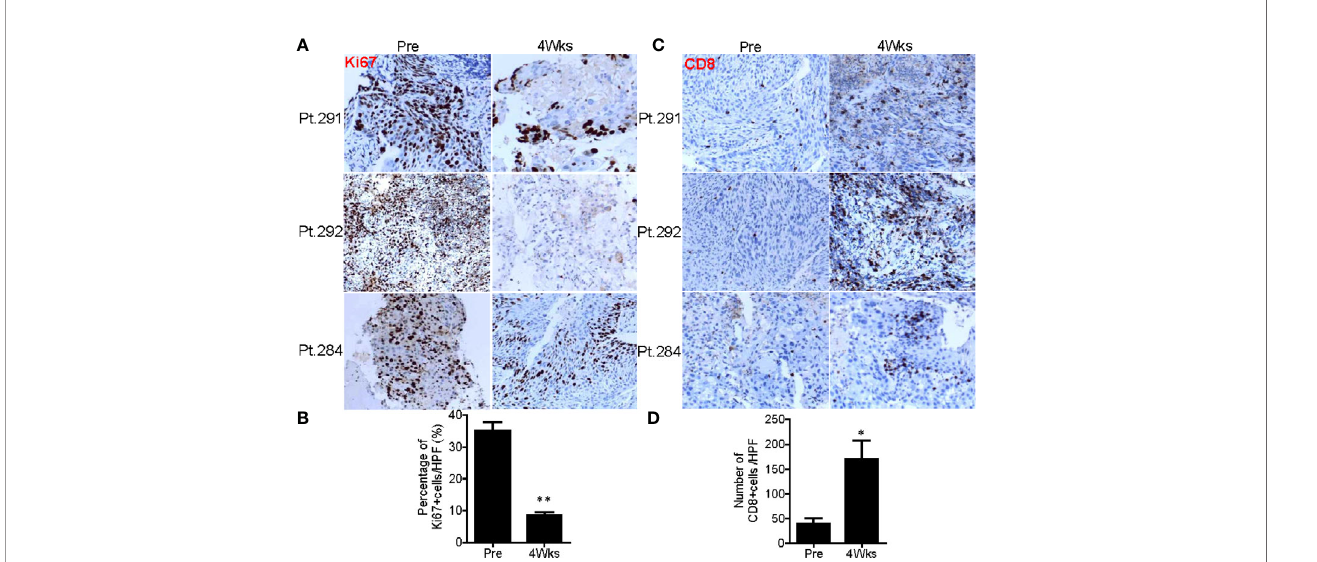
FIGURE 10 | SNCP- 125 I brachytherapy enhances tumor lymphocyte in fi ltration. (A) Immunohistochemistry (IHC) staining against a tumor cell proliferation maker Ki67 in Patients 284, 291 and 292 at pre and 4 weeks post SNCP- 125 I brachytherapy. (B) Quanti fi cation data showed tumor proliferation was signi fi cantly inhibited after SNCP- 125 I brachytherapy ( p =0.013, n=4). (C) IHC staining against tumor in fi ltrated CD8+T cell in Patient 284, 291 and 292 at pre and 4 weeks post SNCP- 125 I brachytherapy. (D) Quanti fi cation data showed a signi fi cant increase in tumor in fi ltrated CD8+T cells after treatment ( p =0.043, n=4). A student t test was used to analyze the statistical signi fi cance before and after treatment. All images were taken in a ×20 magni fi cation and zoomed out. Data were collected under a high-power (×40) fi eld. HPF, High power fi eld. *, p<0.05; **,